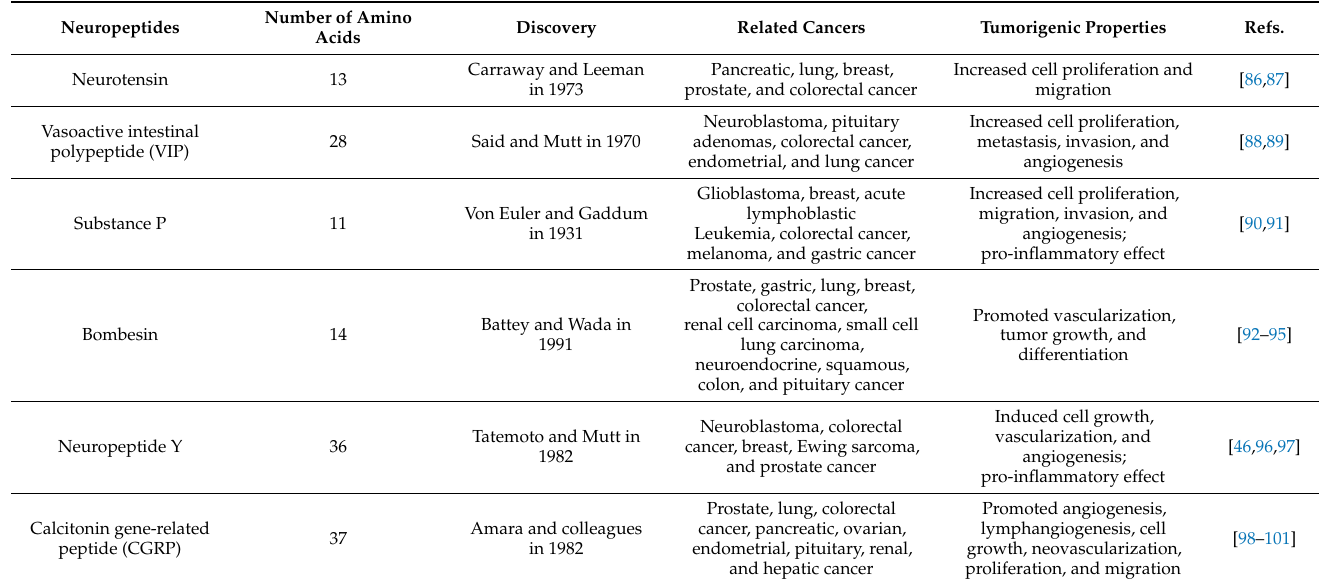
Table 2. NPs related to cancer development and progression and their main